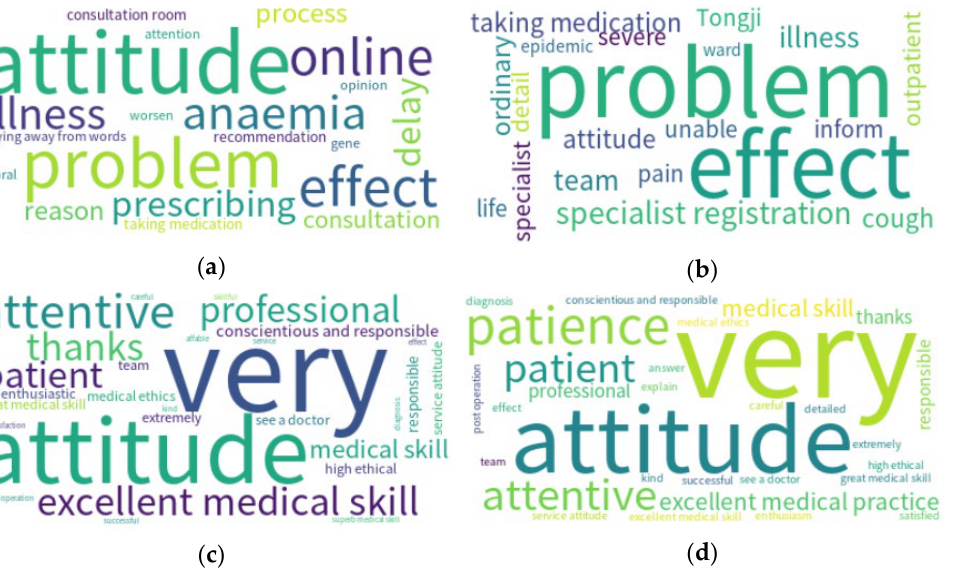
Figure 3. Doctors review from Hubei: ( a ) negative before the pandemic, ( b ) negative during the pandemic, ( c ) positive before the pandemic and ( d ) positive during the pandemic.